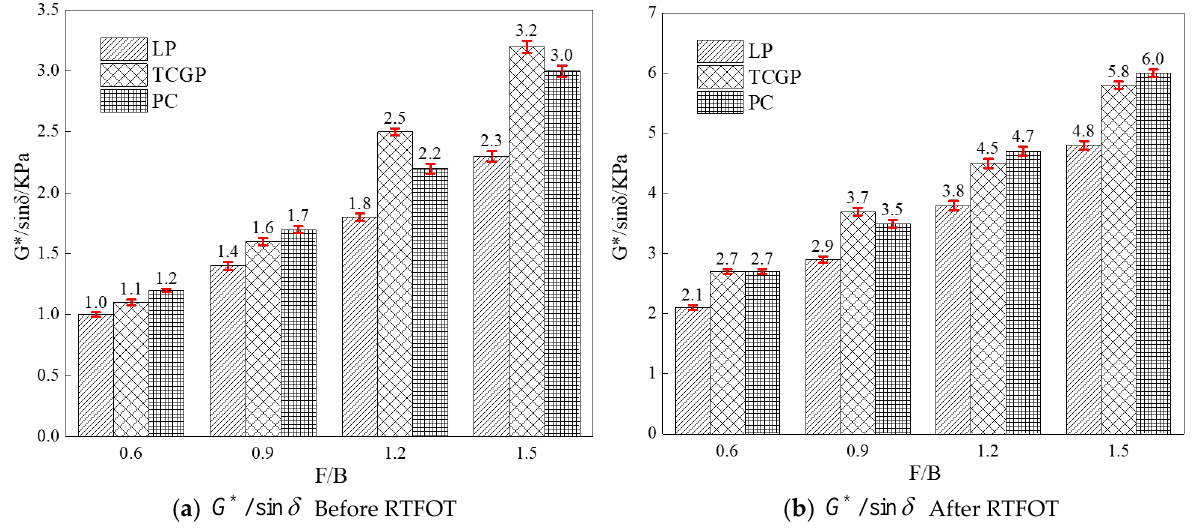
Figure 6. Effect of filler type and F/B on * / sin G  of emulsified asphalt mastics (58 ℃ ).